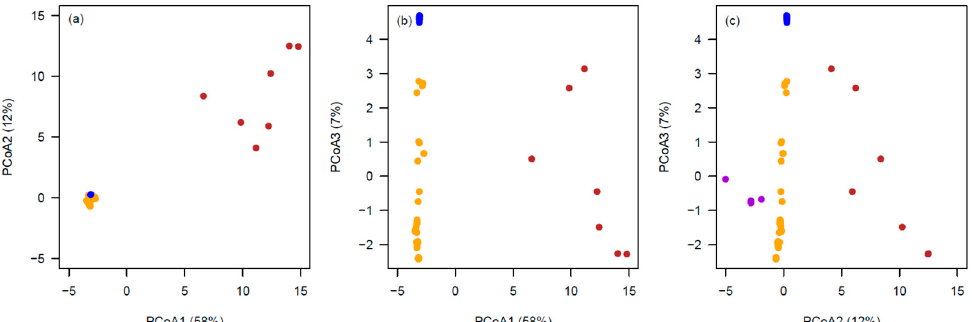
Figure 2. Analysis of main components (PCoA) for estimating genetic structure patterns of forage oat genotypes used in this study: with ( a ) first two components, ( b ) first and second components, and ( c ) second and third components. The percentage of variation explained by each component is shown within parenthesis in the label of the corresponding axis. Axes are drawn to the same scale to make comparisons. Different colors represent groups.